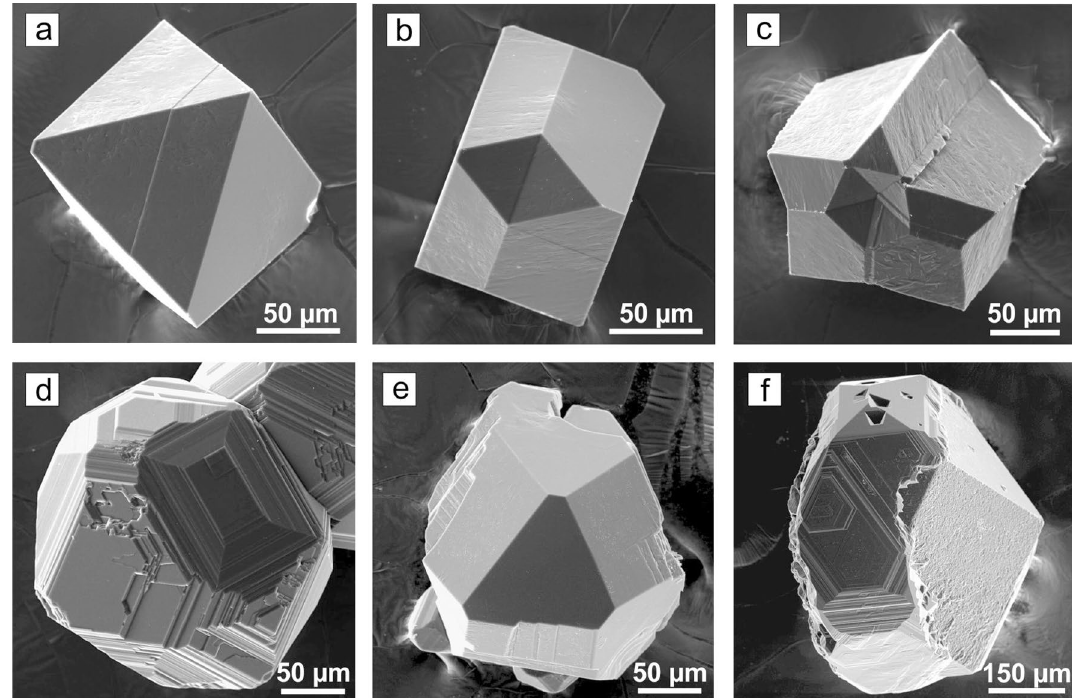
Figure 1. SEM micrographs of diamond crystals synthesized in REM-C systems. ( a ) An octahedral crystal, La–C system; ( b ) a contact twin of octahedral crystals, Ce–C system; ( c ) a cyclic twin of octahedral crystals, Ce–C system; ( d ) crystal of cuboctahedral habit with additional faces, Gd–C systems; ( e ) cuboctahedral crystals, Dy–C system; ( f ) diamond grown on a seed, Ho–C 1900 °C, individual cube–octahedral diamond crystals (~ 80 μm) located at the graphite–metal interface were found. At 2000 °C, colorless, gray, and light brown cube–octahedral diamonds up to 500 μm in size were synthe-